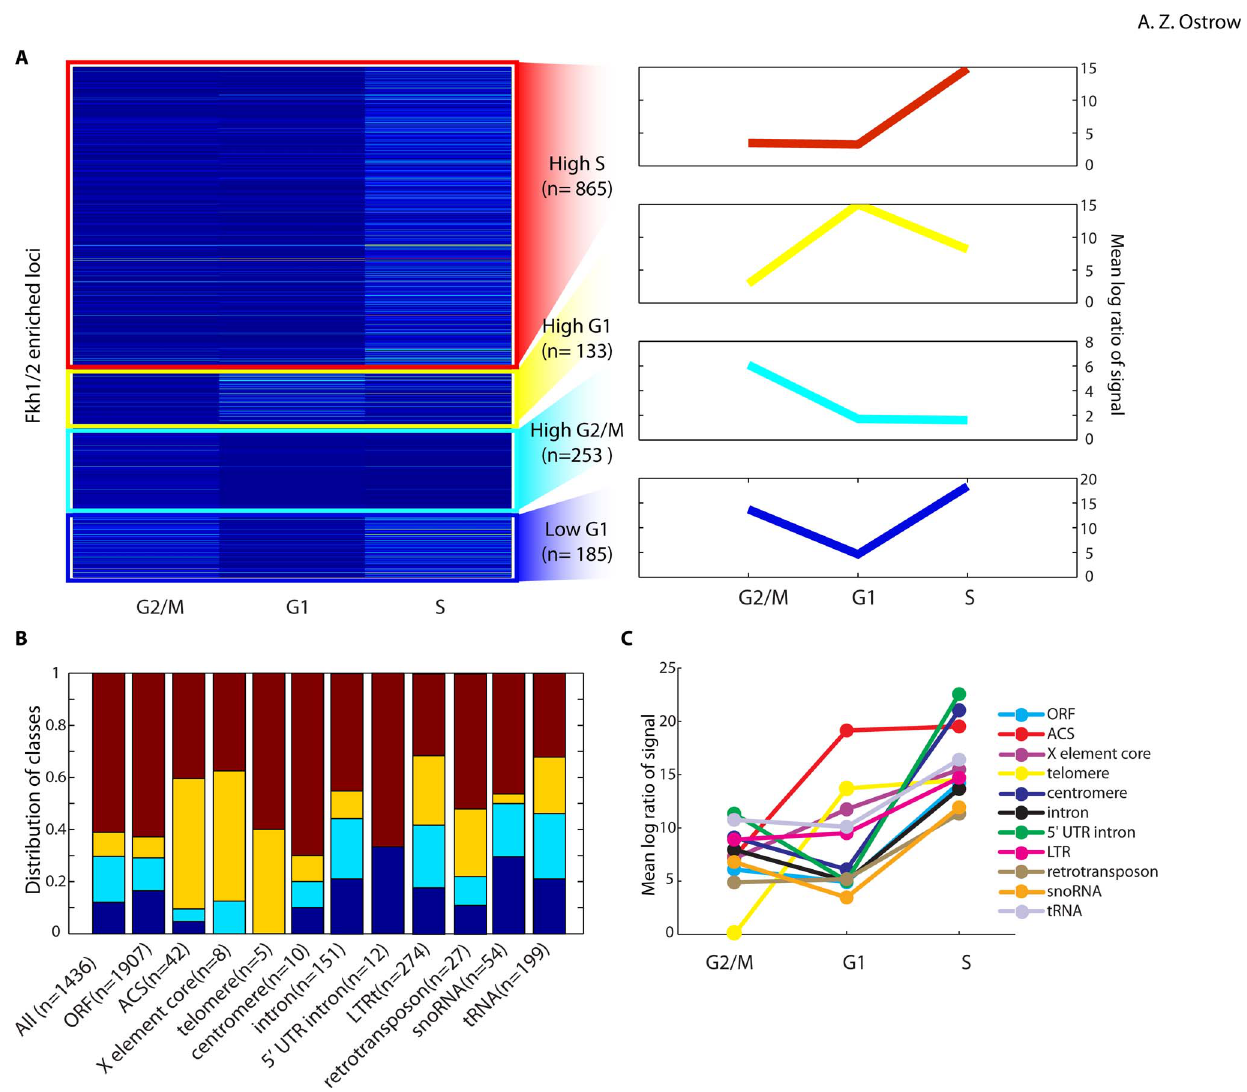
Figure 7. Cell cycle analysis of Fkh1 and Fkh2 binding. A ) The k-means cluster-gram on the left shows the average signal intensity of individual binding loci across the three experiments, divided into four groups, which was found to account well for the data. The graphs to the right of each cluster show the averaged signal of all sites in the cluster. B ) For each class of genetic element indicated, the number of proximal ( + / 2 500 bp) Fkh1 and Fkh2 binding loci in each of the four clusters in ( A ) was counted to determine the distribution of these binding sites amongst the four clusters. The colors in the graph correspond to the colors of the four clusters in ( A ). C ) The average signals of Fkh1 and Fkh2 binding loci proximal ( + / 2 500 bp) to the indicated genetic element class was determined and plotted for the three cell cycle